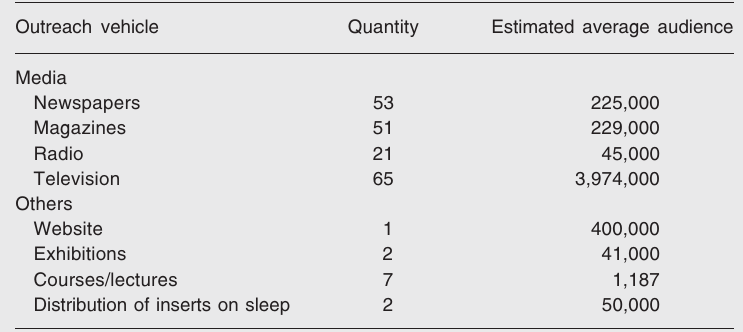
Table 1. Outreach initiatives and estimated audience of the Sleep Medicine Program (2001-2004). Outreach vehicle Quantity Estimated average